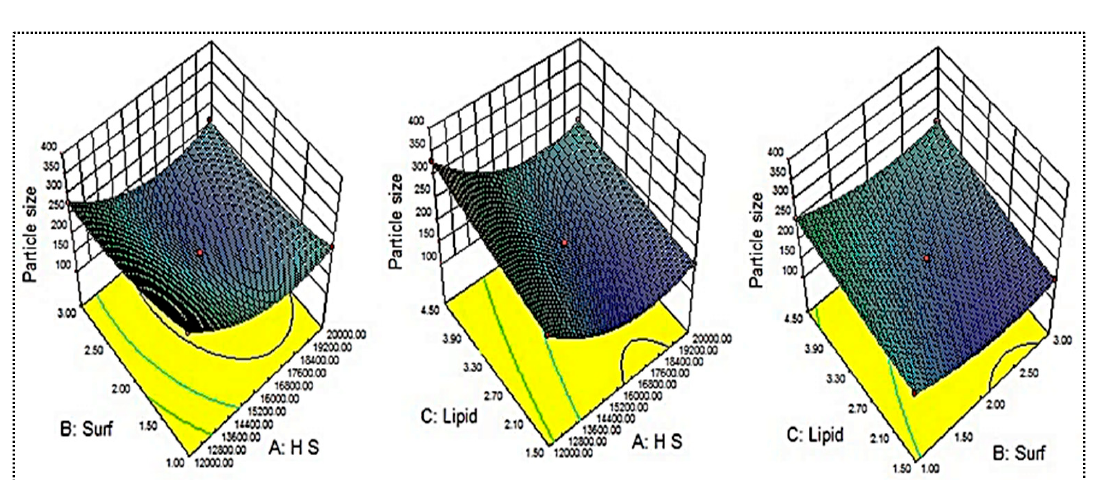
Figure 2. Effect of independent variables (Homogenization speed—A, Surfactant—B, Lipid—C) on the particle size (Y 1 ).